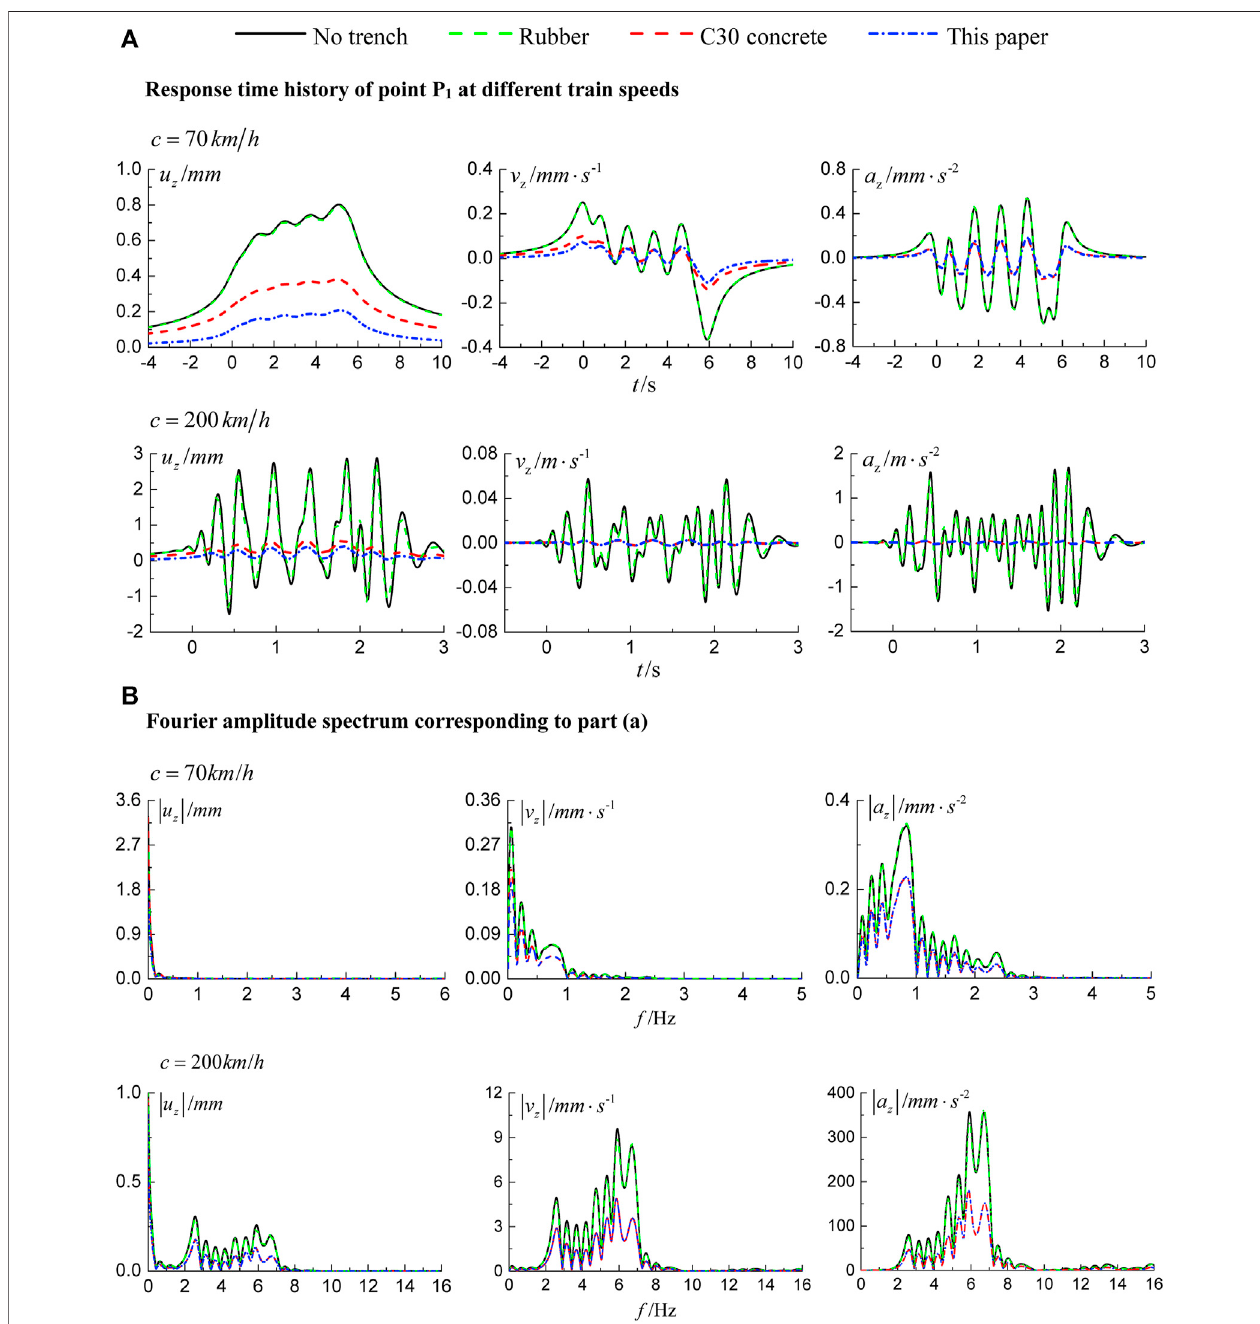
FIGURE 2 | In fl uence of trench type to isolation effect on soft